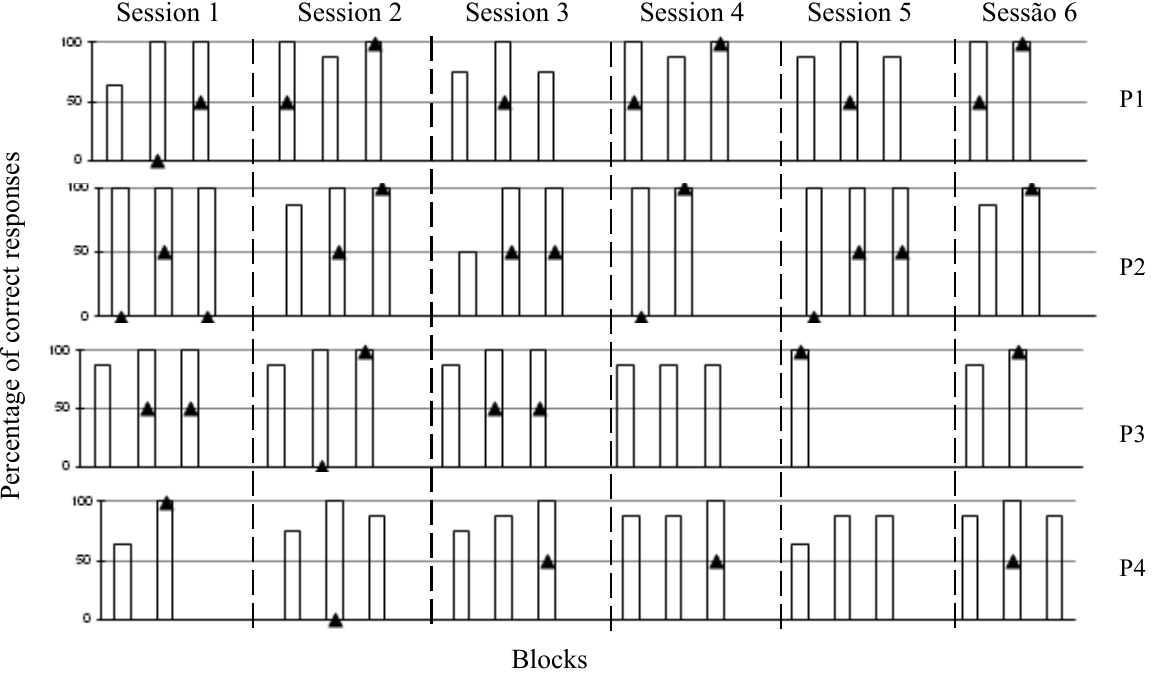
Figure 2 . Percentage of correct responses in selection (white bars) and naming (black triangle) blocks in each session for each of the participants of Study 1.